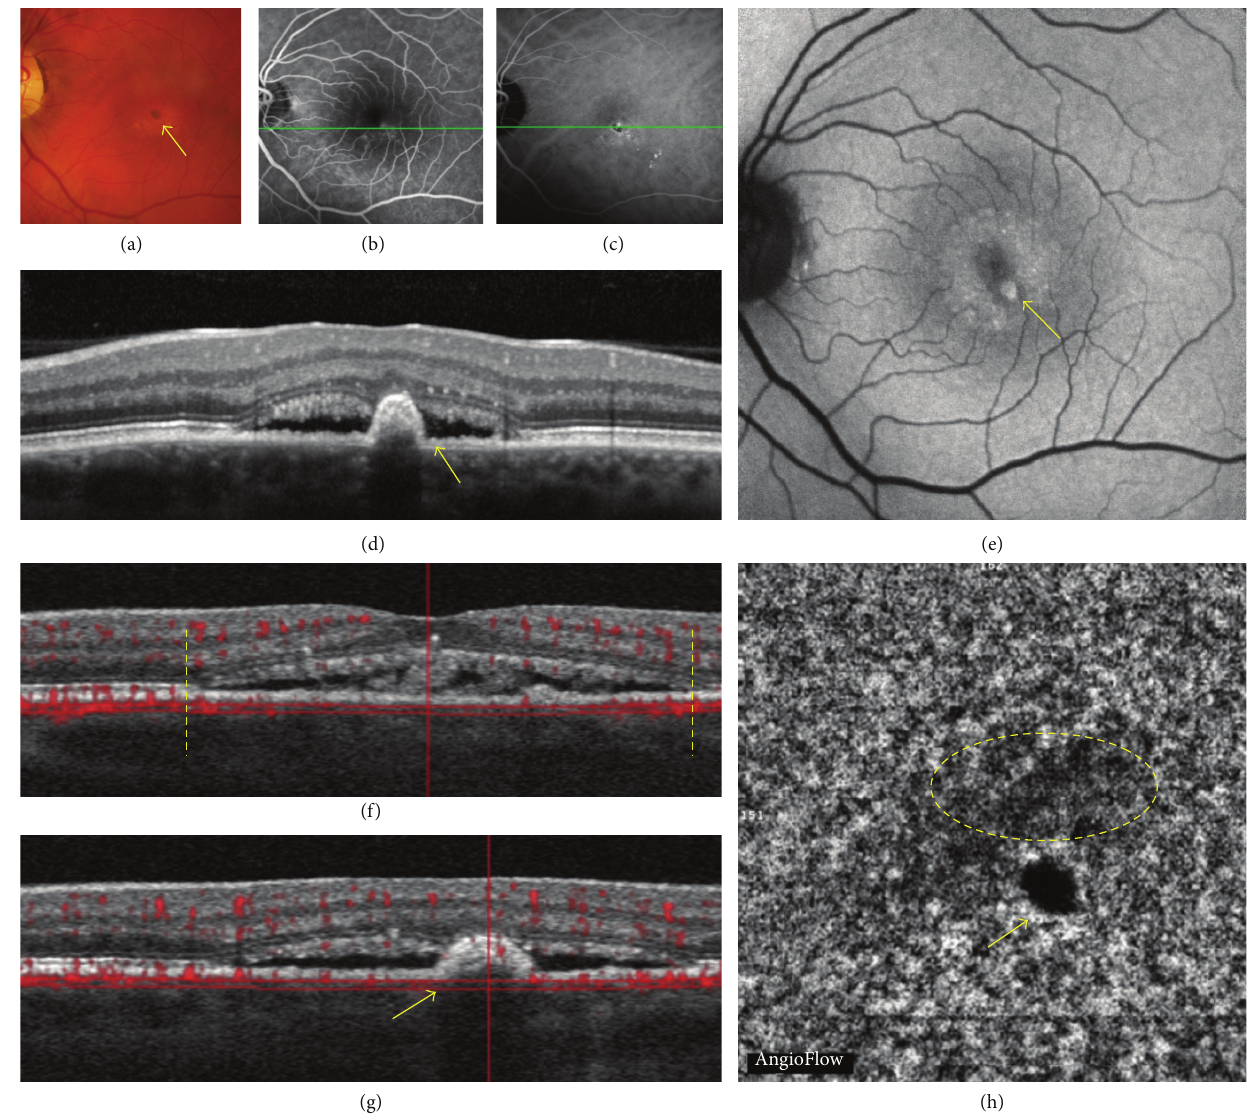
Figure 3: Recurrent central serous chorioretinopathy in a 61-year-old man. Multimodal imaging versus OCT angiography (OCTA). Multimodal imaging showing the correlation between color photography (a), fluorescein angiography (FA (b)), indocyanine green angiography (ICGA (c)), optical coherence tomography (OCT (d)), fundus autofluorescence (FAF (e)), and OCT angiography (OCTA (h)) with segmentation at the level shown on coregistered OCT B-scans ((f) and (g)). The color fundus photography showed pigmentary changes; the yellow arrow indicates a hyperpigmentation dot. Uneven leakage of dye ((b) and (c)). OCT B-scan showed a serous retinal detachment (SRD). Hyperautofluorescence with hyperautofluorescent parafoveal dots (arrow). Coregistered OCT B-scan showing the segmentation shown in (h): the yellow vertical lines indicate the limits of the SRD. Coregistered OCT B-scan at the level of the yellow arrow shown in (h): the yellow arrow indicates the small area of retinal pigment epithelium detachment. OCTA showed a moderately dark area delineated by a yellow dashed